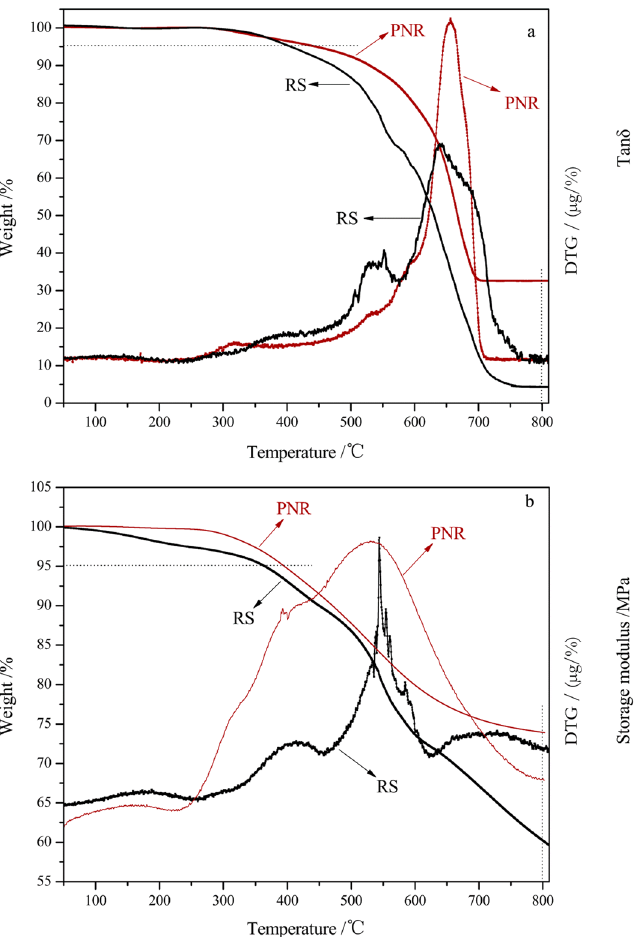
Figure 8: DMA curves of the PNR and RS: ( a ) tan δ and ( b ) storage